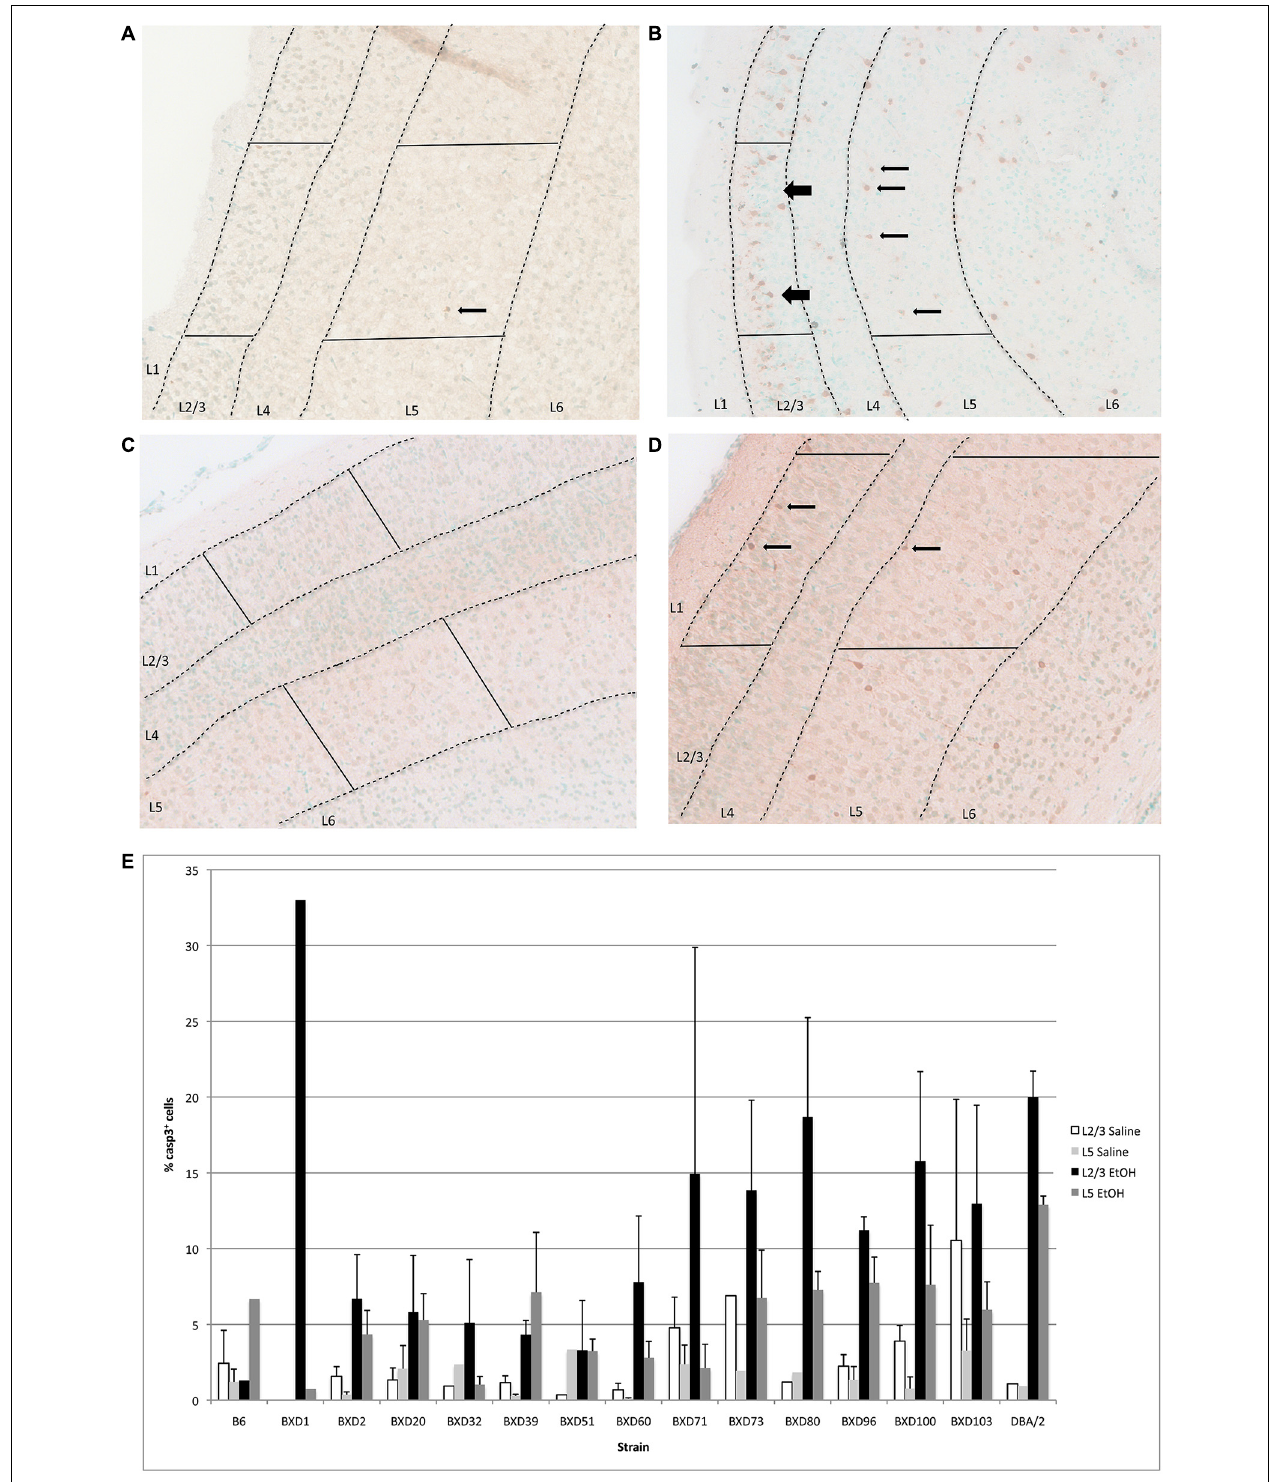
FIGURE 3 | (A) Cell death is shown in the cortex overlying the hippocampus of a region of a relatively resistant (BXD20) strain, and (B) a region of a relatively susceptible (BXD80) strain. (C,D) Saline controls for BXD20 and BXD80, respectively. Boxes highlight the area analyzed, dashed lines demarcate Layers 2/3 and 5, and arrows point to dying cells. (E) Cell death in cortex is plotted for Layers 2/3 and 5 as mean +